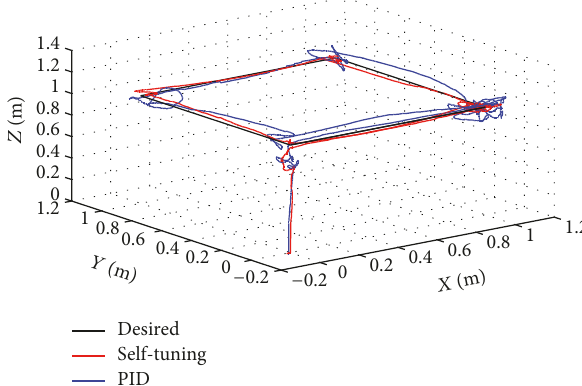
Figure 21: Three-dimensional response curves of quadrotor UAV position (𝑥,𝑦,𝑧) with variable payload